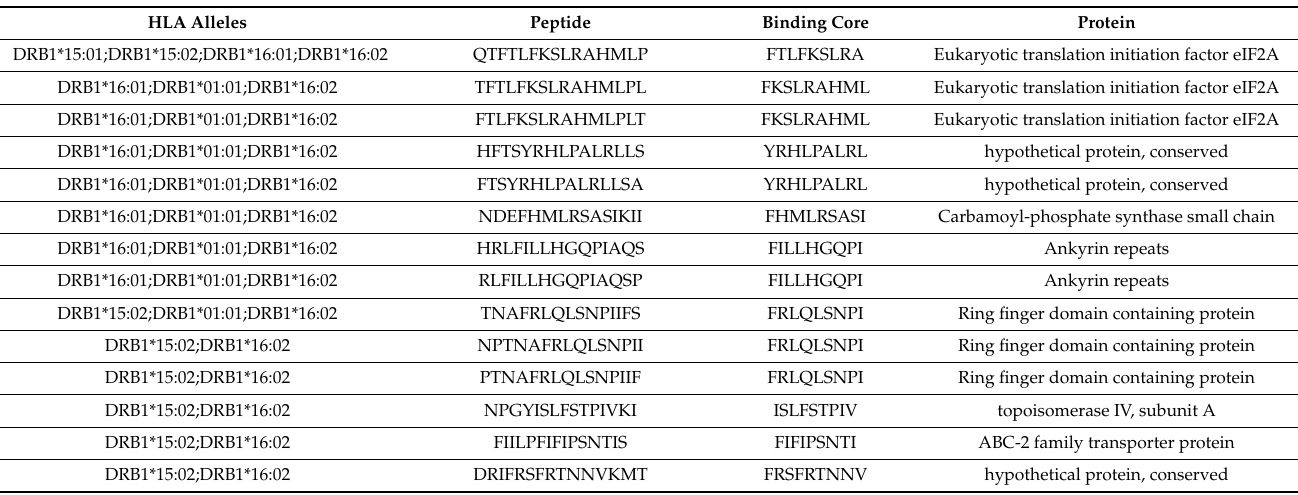
Table 3. Prioritized in silico predicted strong-binding epitopes that are (A) conserved across the included species and (B) bind across different HLA alleles. Ranked by the number of HLA alleles and the protein these epitopes are derived from. HLA Alleles Peptide Binding Core